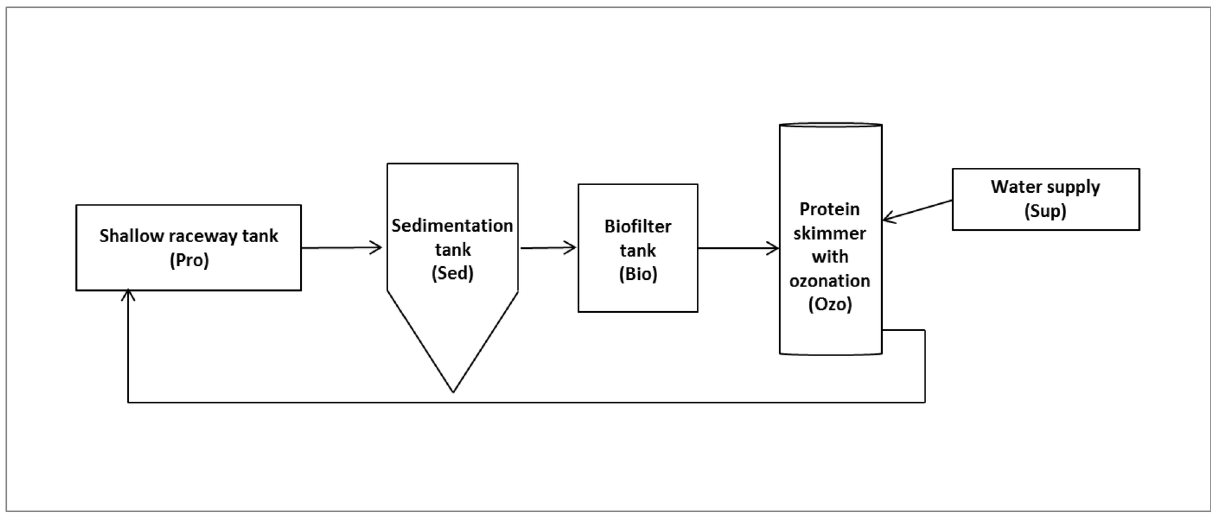
Figure 1. Schematic representation of the sampling compartments in RAS. Water circuit of the recirculating aquaculture system studied (not to